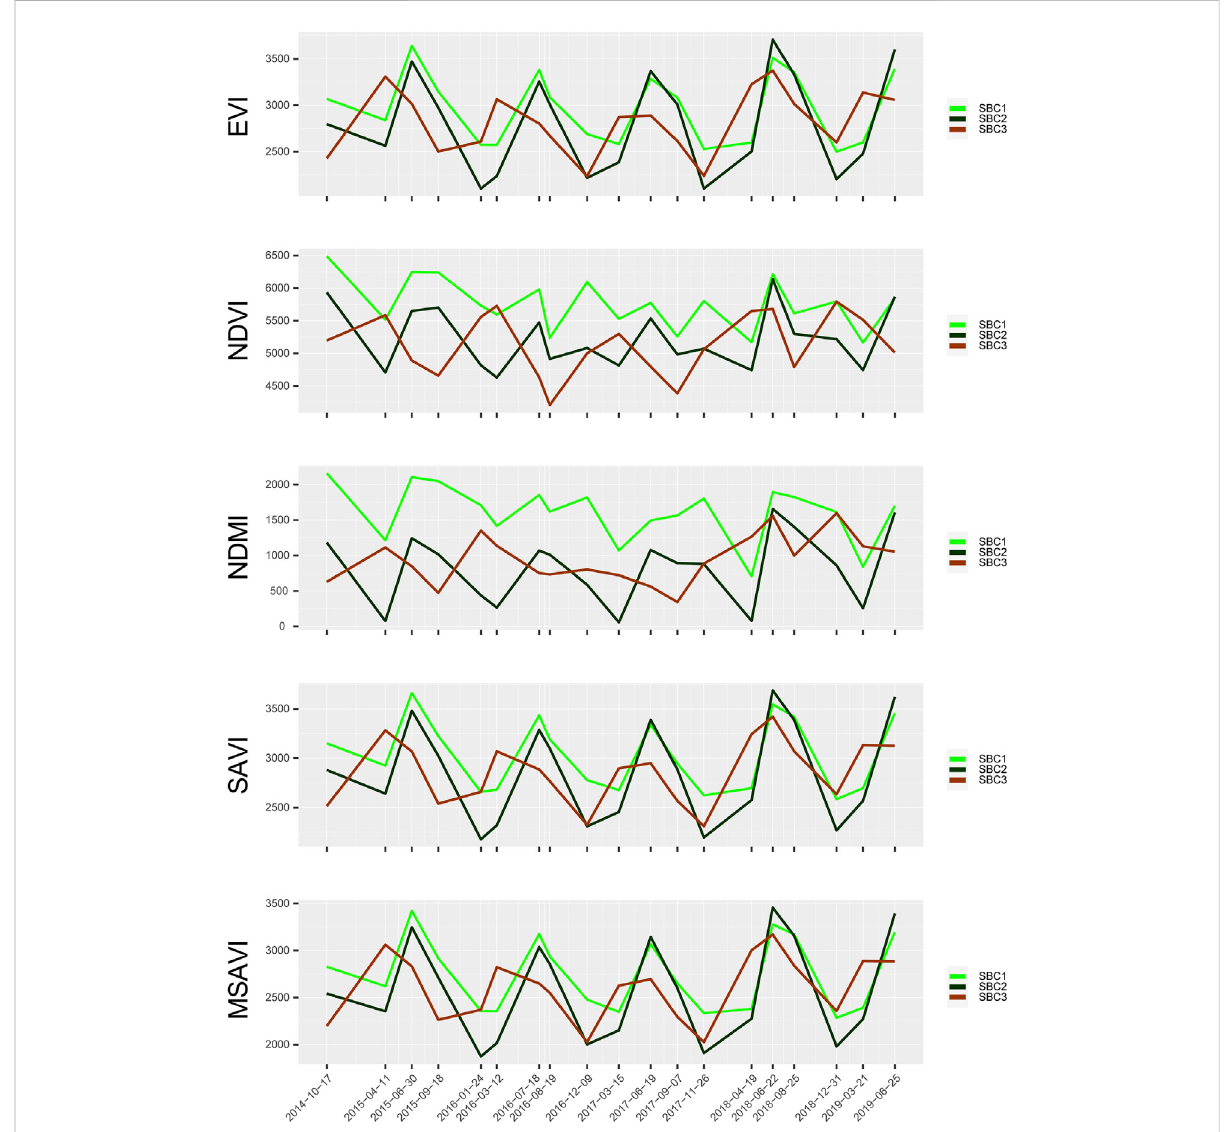
FIGURE 2 Enhanced vegetation index (EVI), normalized difference vegetation index (NDVI), normalized difference moisture index (NDMI), soil-adjusted vegetationindex(SAVI),andmodi fi edsoil-adjustedvegetationindex(MSAVI)meanvaluesfromLandsat8-OLIforthe19samplingcampaignsdivided by the three studied sub-catchments (SBC1, SBC2, and